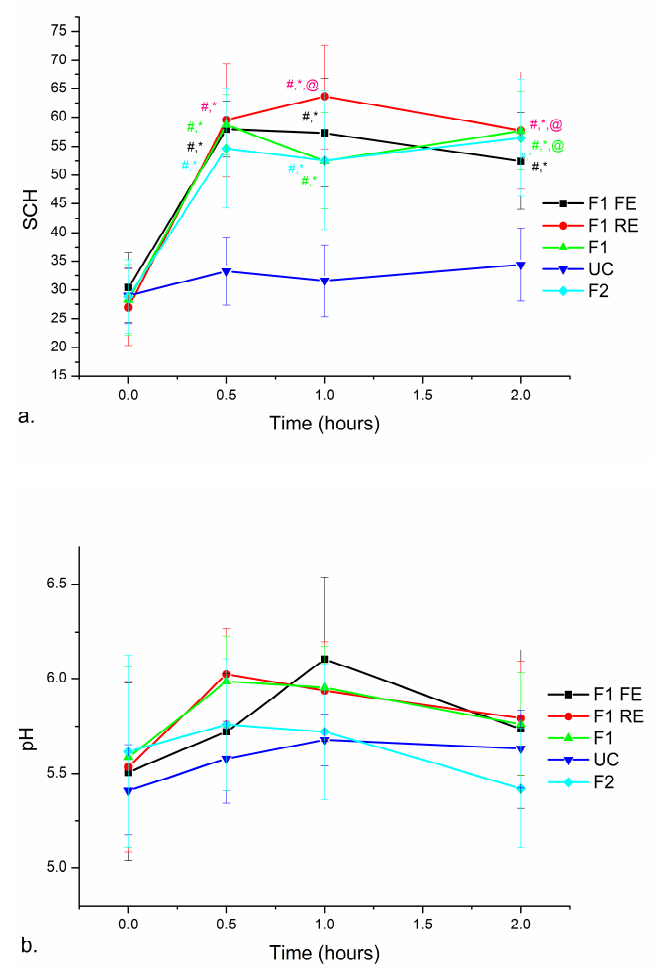
Figure 8. ( a ) The effects of topical application of the samples on SCH in a short-term study. Significant differences ( p < 0.05) being marked with (#) for the difference to untreated control (UC), with (*) for the difference to baseline and with (@) for the difference to all other investigated samples; ( b ) skin pH values as a function of time (hours) after nanoemulsion